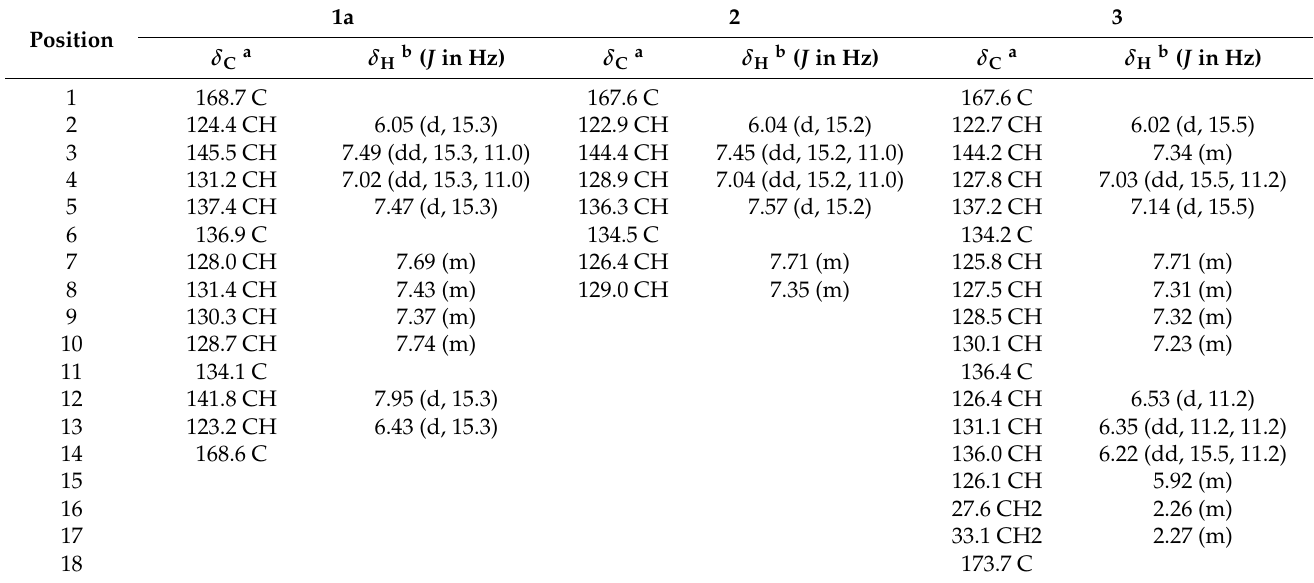
Table 1. NMR data for 1 − 3.